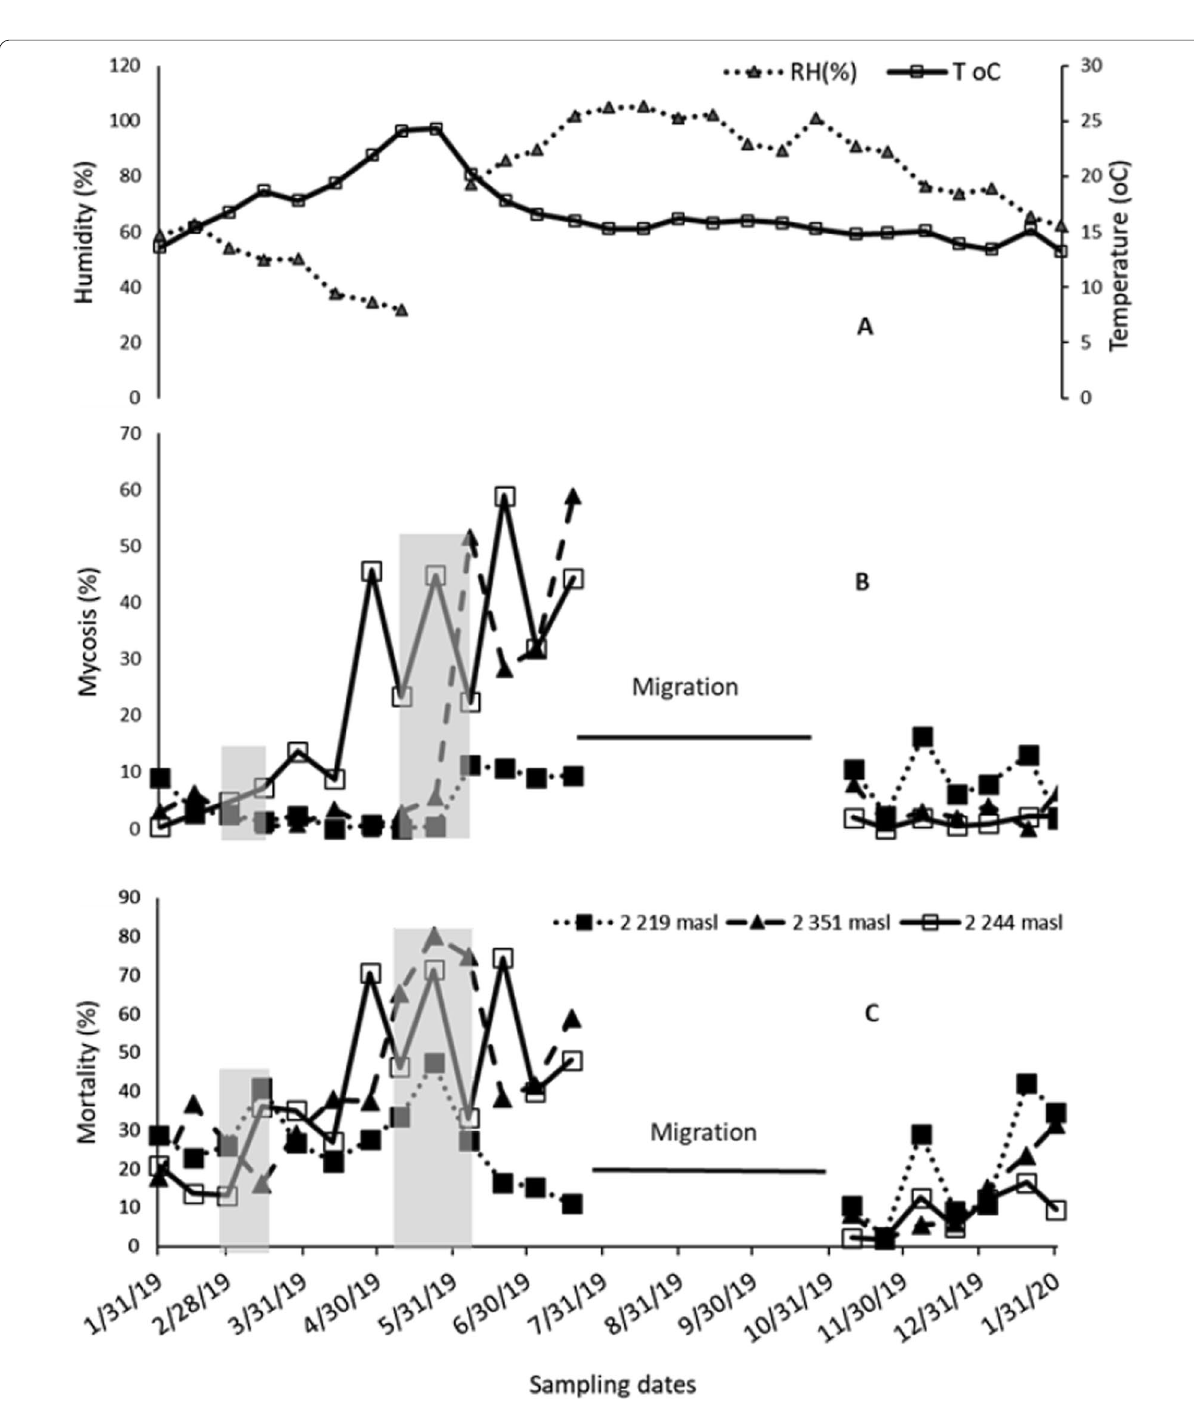
Fig. 4 Mortality (mycosed non‑mycosed ( C ), and mycosed corpses in field ( B ) of Oebalus mexicana , and A Relative humidity (RH) and + temperature in the microenvironment of the overwintering sites of the Zináparo hill, Michoacán, México. 2019–2020. Gray bar indicates swarm